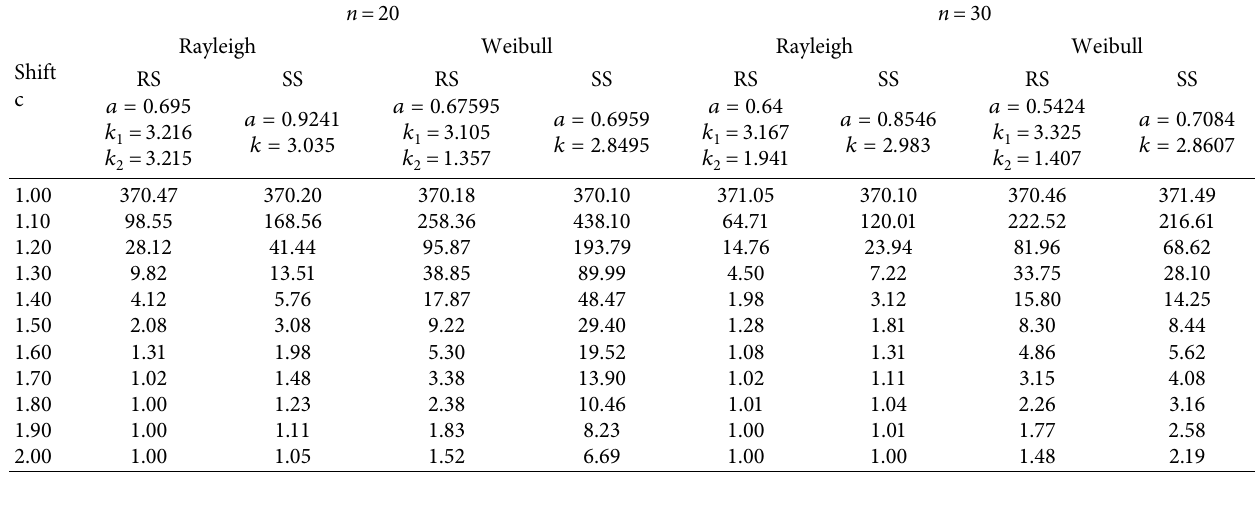
Table 6: ARL values of attribute control chart under repetitive sampling (RS) and single sampling (SS) for Rayleigh and Weibull dis- � 370. tributions when ARL 0